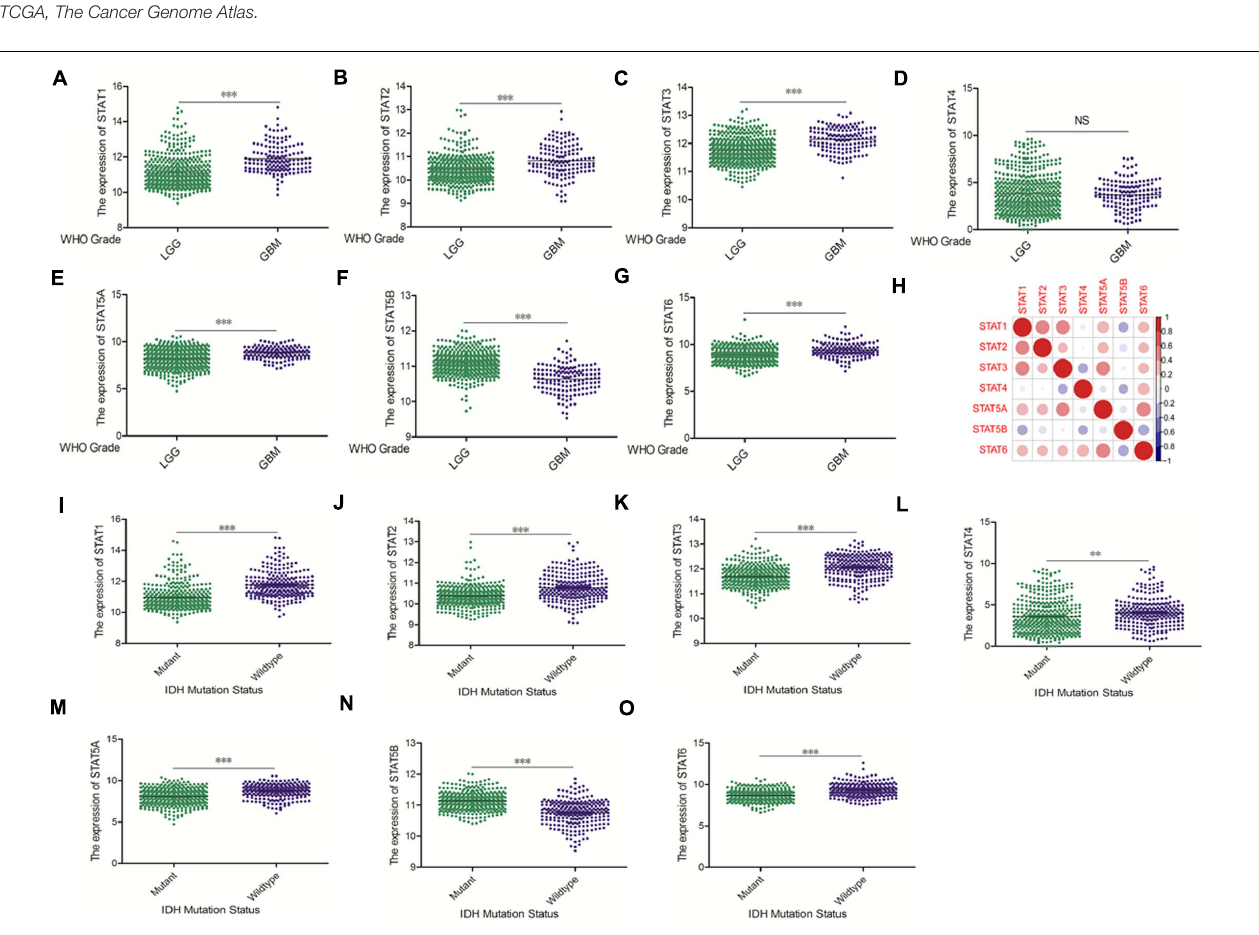
FIGURE 2 | mRNA expression levels of STATs in glioma (using TCGA database). (A–G) mRNA expression levels of STAT genes in LGG and GBM ( ∗∗ p < 0.01 and ∗∗∗ p < 0.001). (H) Co-expression heat map of STAT genes in glioma. (I–O) Correlation between STAT genes expression and IDH mutation status in